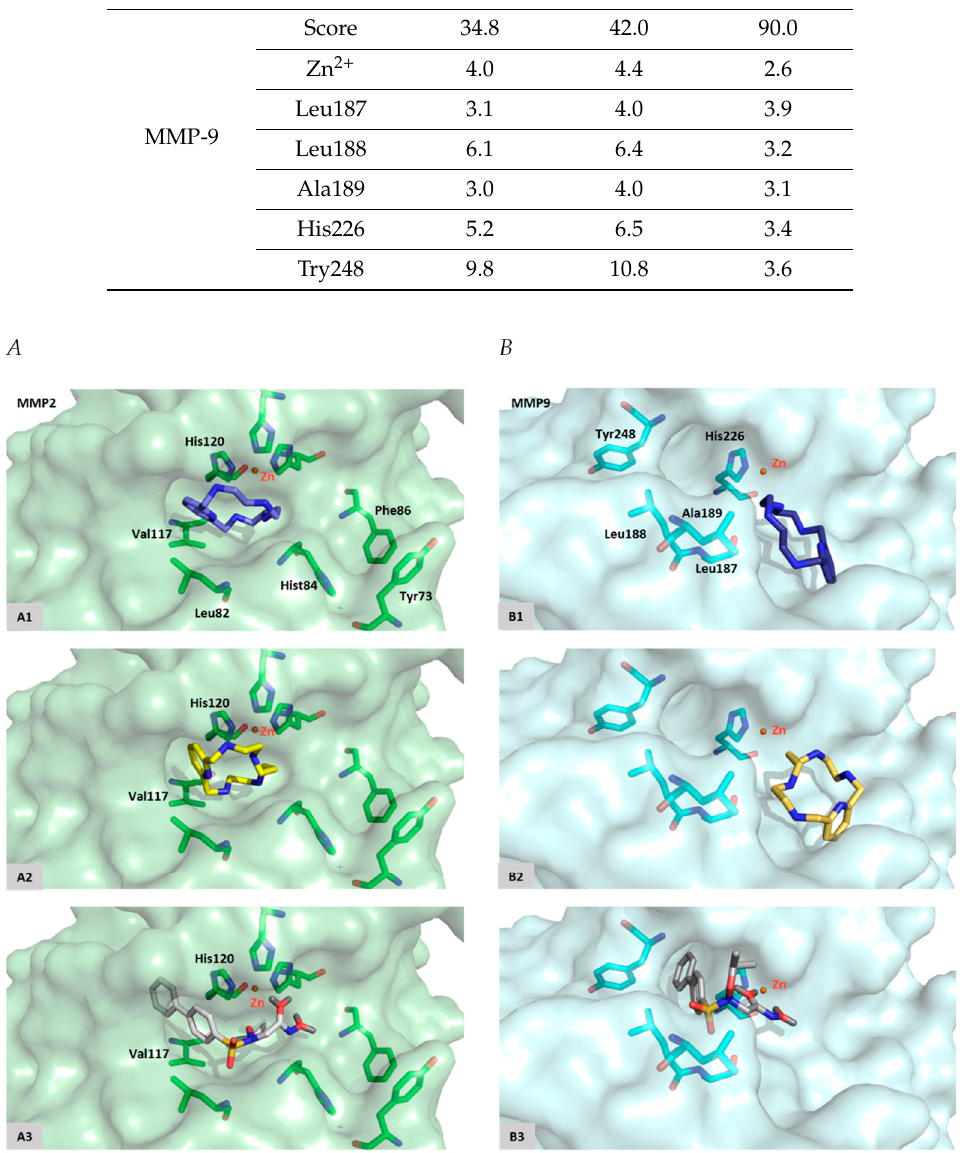
Figure 7. Docking poses. ( A ) MMP-2 active site with [15]pyN 5 ( A1 ), [16]pyN 5 ( A2 ) and ARP-100 ( A3 ); ( B ) MMP-9 active site with [15]pyN 5 ( B1 ), [16]pyN 5 ( B2 ) and ARP-100 ( B3 ). 2.6. Cell migration is Significantly Impaired by [15]pyN 5 and [16]pyN 5